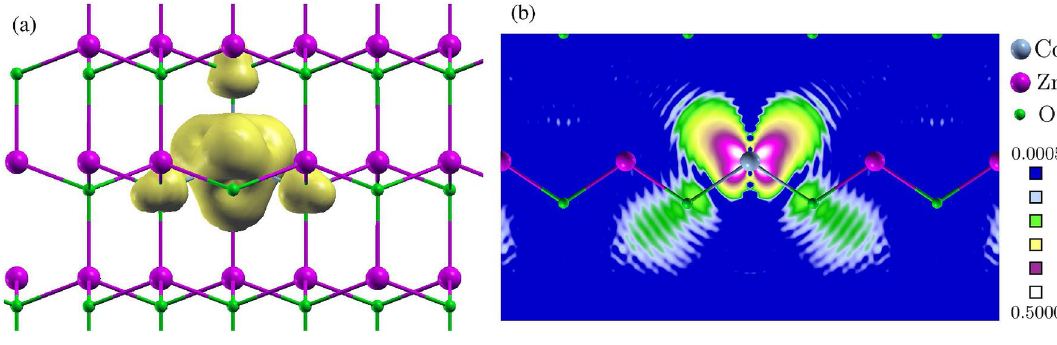
Figure 3. ( a ) Spin density, n ↑ − n ↓ , of ZnO with Co 2+ (the isosurface value is 0.002 electron/Bohr 3 ) and ( b ) 1 / 3 − n 1 / 3 two-dimensional plot of n ↑ ↓ in the plane containing Co–O